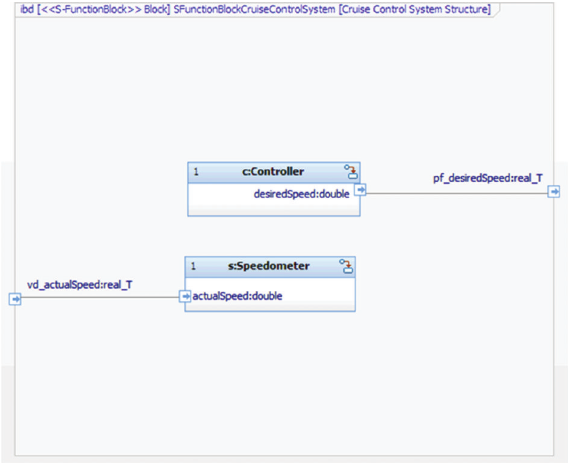
Figure 6: Internal block diagram of generated S-Function